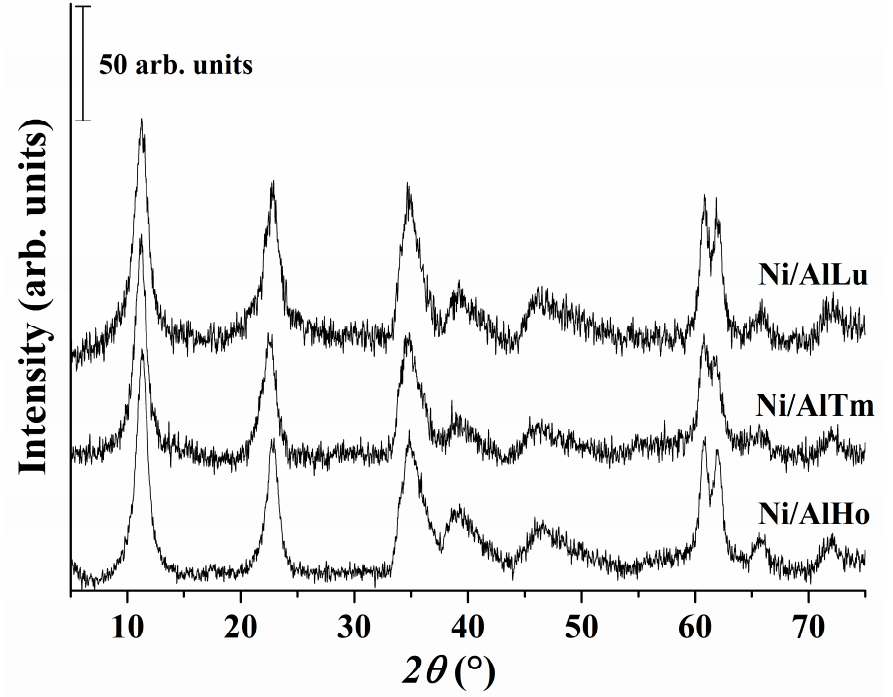
Figure 1. XRPD pattern of as-synthesized lanthanide-containing layered double hydroxides.